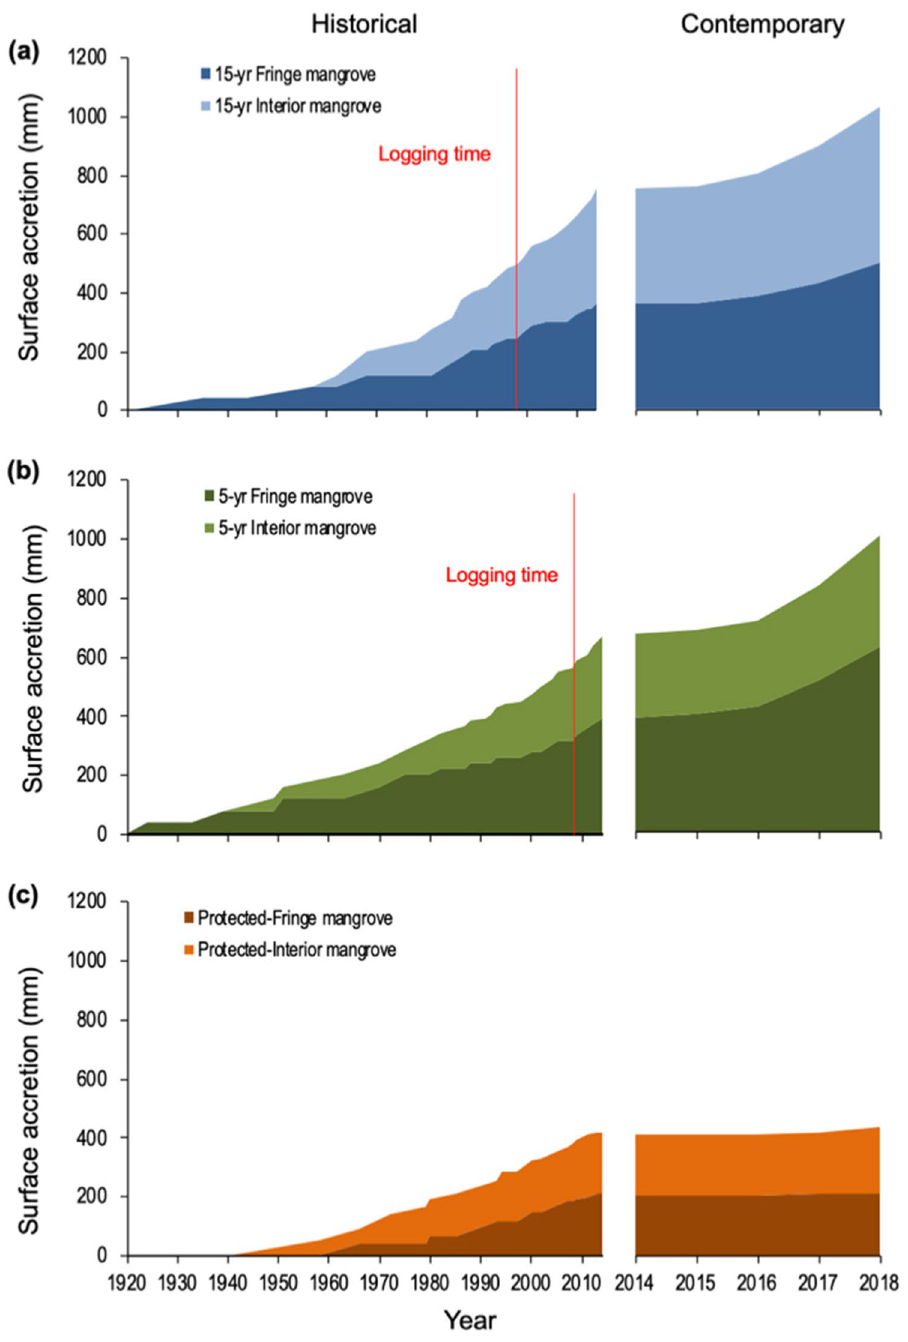
Figure 5. Historical cumulative vertical accretion derived from 210 Pb radionuclide technique (left-hand panels) and contemporary vertical accretion from marker horizons (right-hand panels), measured in different hydro- geomorphic settings and stand ages: ( a ) 15-year-old stands; ( b ) 5-year-old stands; and ( c ) protected